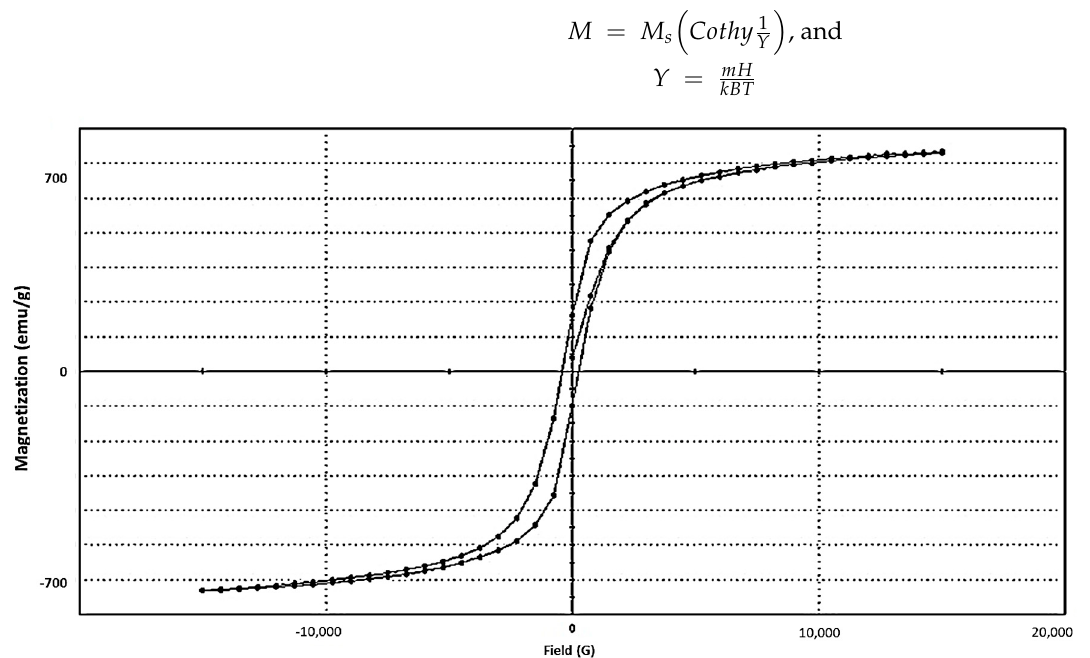
Table 1. The concentration (mg/L) of identified metallic ions present in the effluents.